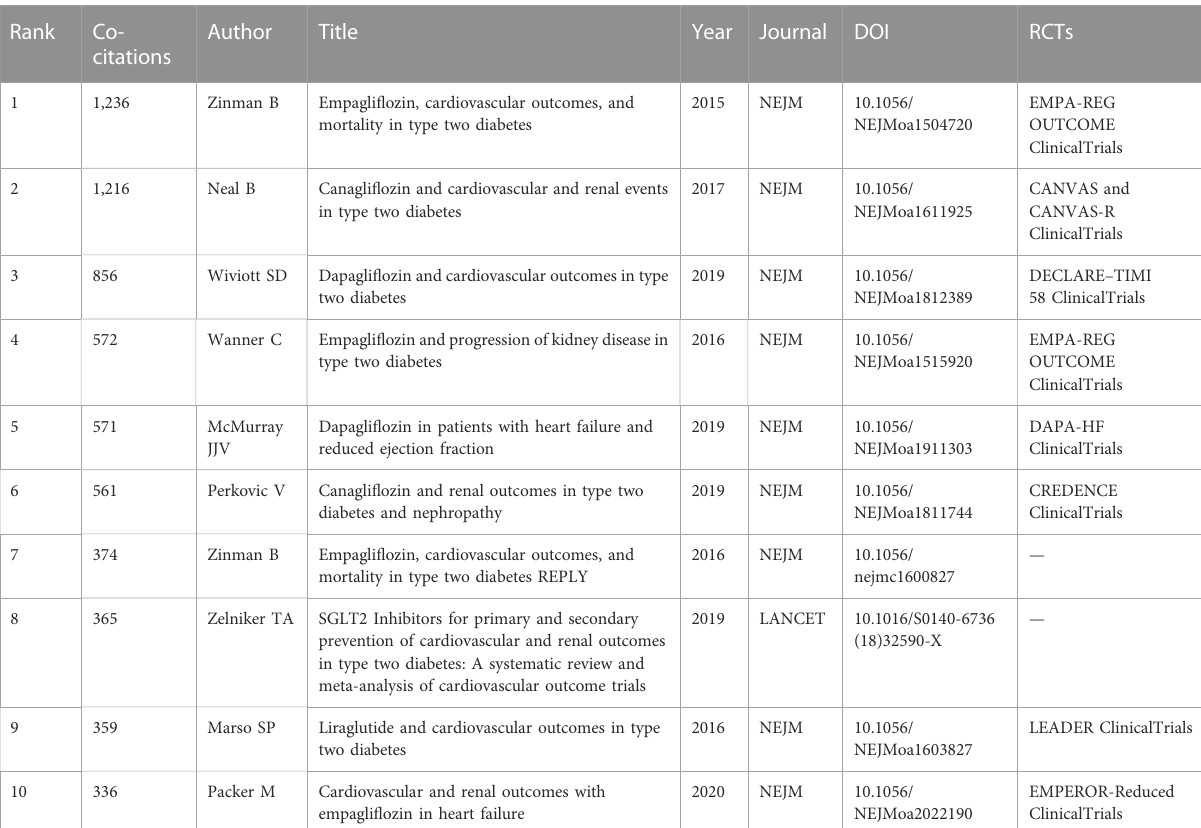
TABLE 4 Top 10 co-cited references in SGLT2 inhibitor